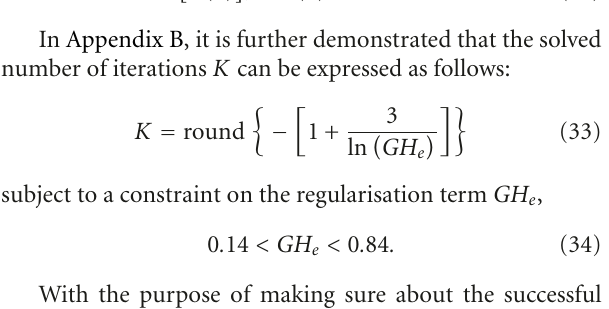
of the fact that the desensitisation change is expected to be maximised, the second derivative of Z ( k ) is herein the aimed function denoted by R ( k